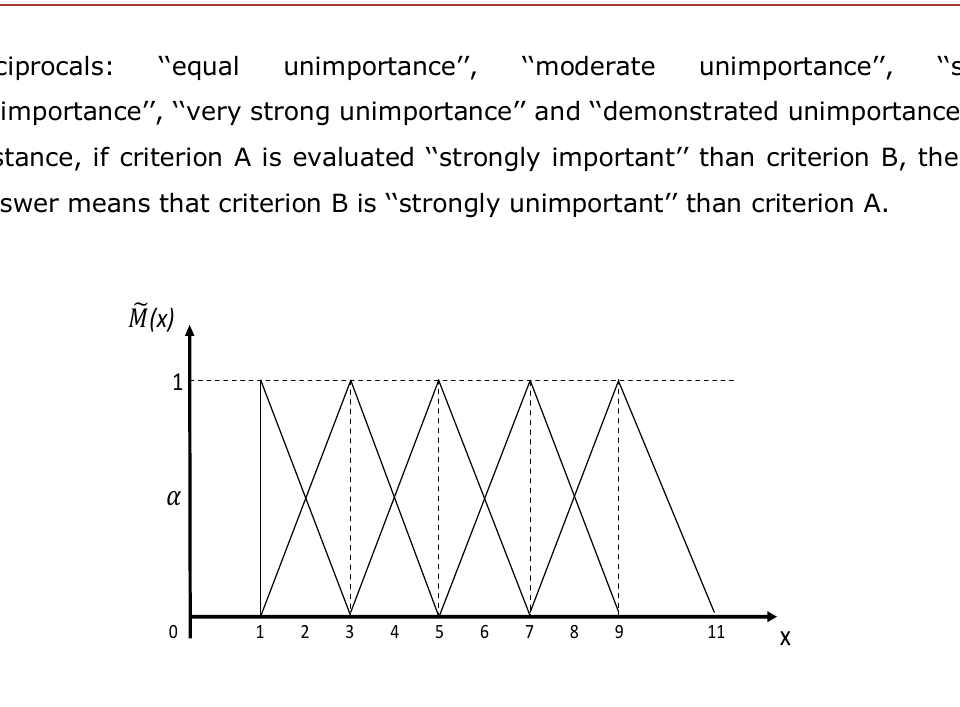
Figure 2. Membership functions of triangular fuzzy numbers corresponding to the linguistic scale